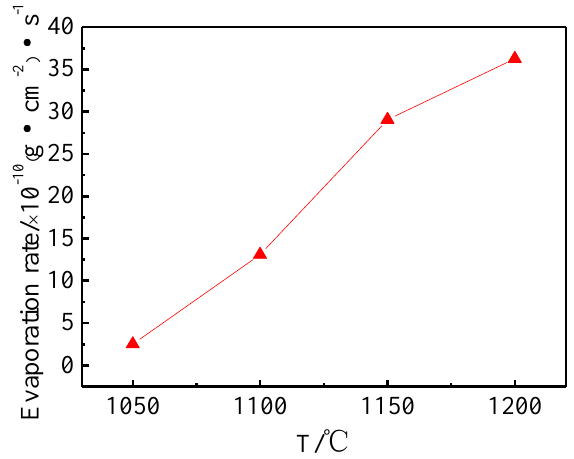
Figure 8. Average evaporation rate of cathodes filled with 6:2.0:2 aluminates at different temperatures.